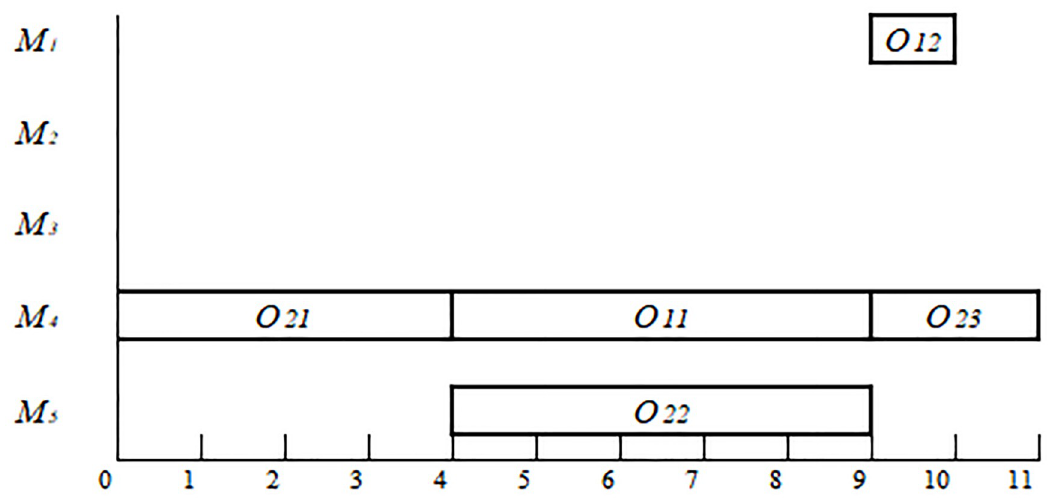
Fig 2. The Gantt chart of a schedule for the example in Table